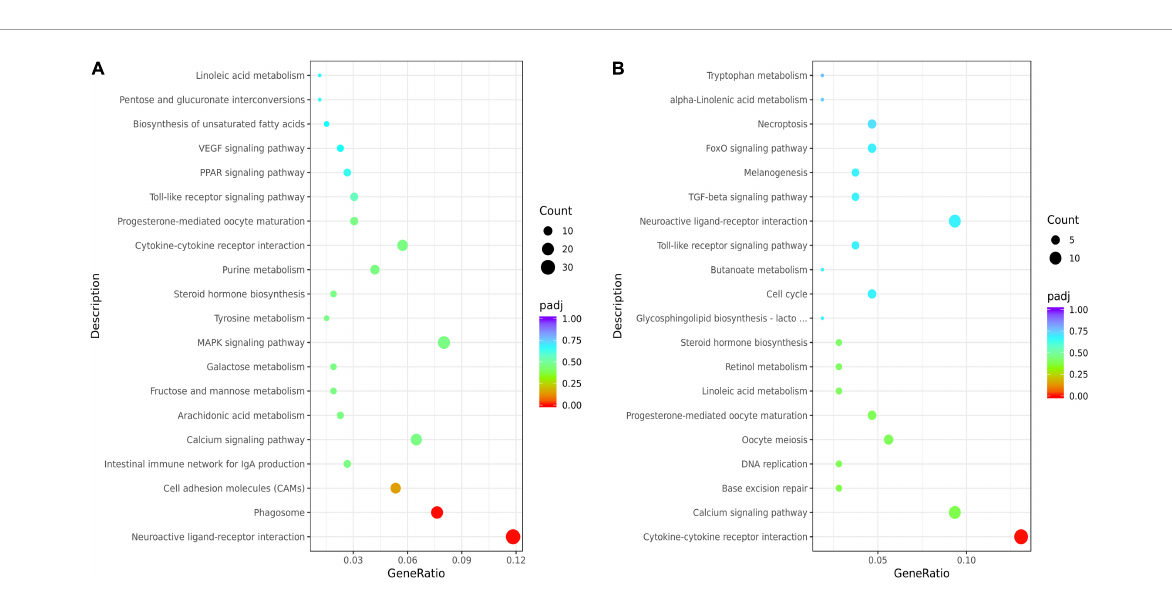
FIGURE3 Kyoto Encyclopedia of Genes and Genomes (KEGG) enrichment analysis of the liver or breast muscle samples affected by linseed oil. (A) Bubble diagram of the top 20 KEGG pathway enrichments for the HL vs. CL comparisons. (B) Bubble diagram of the top 20 KEGG pathway enrichments for the HM vs. CM comparisons. The ordinate indicates the